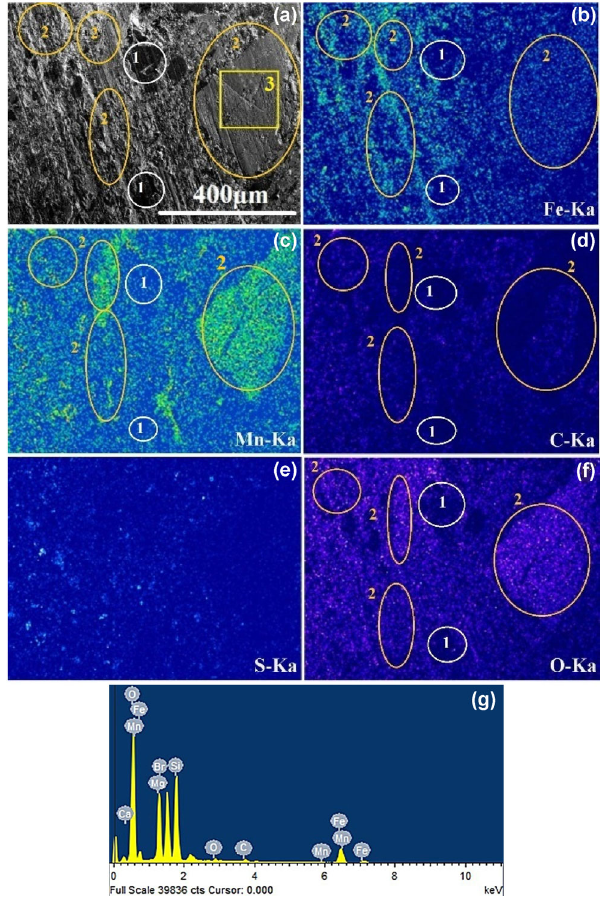
Fig. 12 Worn surfaces of the FM01 composites (a) electron image, with elemental mapping, (b)–(f) electron images with elemental mapping, and (g) EDAX spectra representing back transfer (secondary plateau formation).